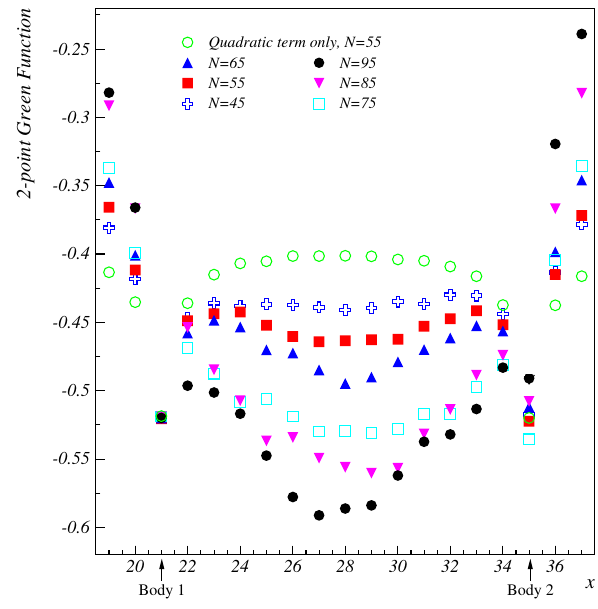
Fig. 17 Potentials computed for different lattice sizes varying from N = 45 to N = 95. The Lagrangian in Eq. (12) is used except for the open circles that show the massless free-field case. The two bodies are located on the x -axis at d = ± 7 from the lattice center x center = 28, y = 0 and z = 0. The coupling is g = 7 . 5 × 10 − 3 . The decorrelation parameter is N cor = 20 and N s = 3 . 5 × 10 4 paths were used. To facilitate comparing the results, a constant offset is added to the data for each N cases so that the data at the position of the first body, x =